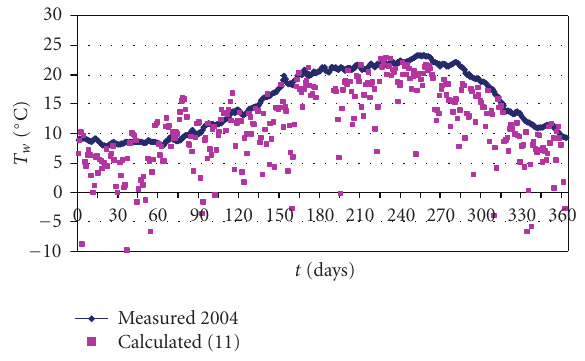
Figure 19: Comparison between measured and estimated data (13), correlation coe ffi cient r Tw , Tw 1 = 0 .